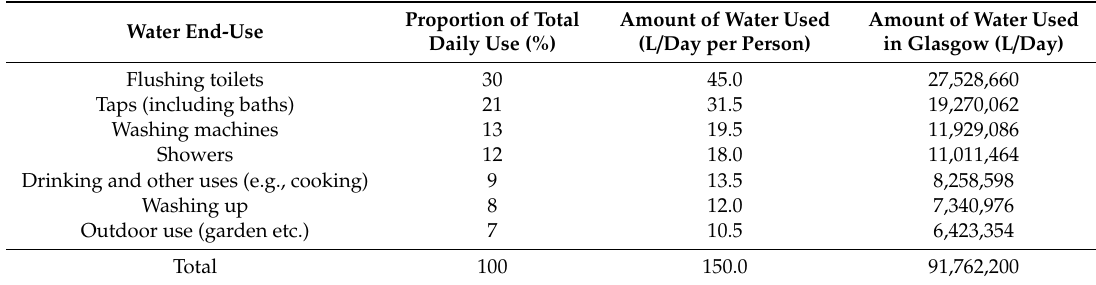
Table 1. Water end-uses in the residential sector in